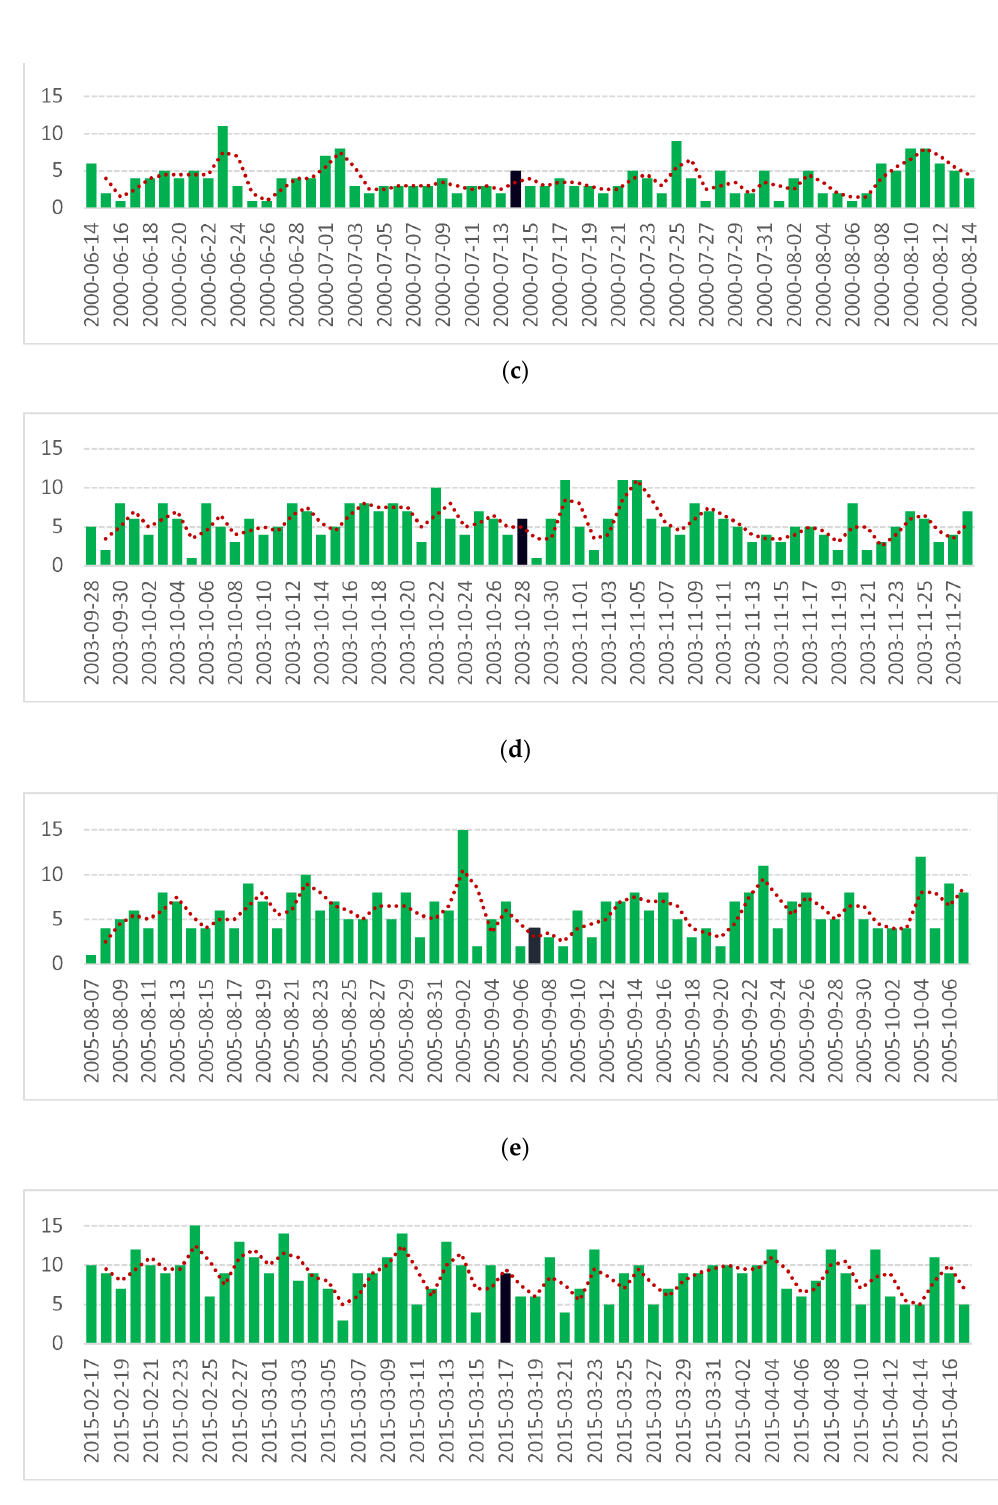
Figure 3. Daily numbers of deaths from diseases of the nervous system (G00–G99) during exceptionally strong solar events in period of years 1994–2015. ( a ) Geomagnetic storm on 7 January 1997, ( b ) X20 class storm on 2 April 2000, ( c ) class X5 storm on 14 July 2000, Bastille Day Event, ( d ) class X17 storm on October 28, 2003, Halloween Solar Storms, ( e ) class X1 storm on 7 September 2005, and ( f ) class G4 storm on 17 March 2015, St. Patrick’s Day event.